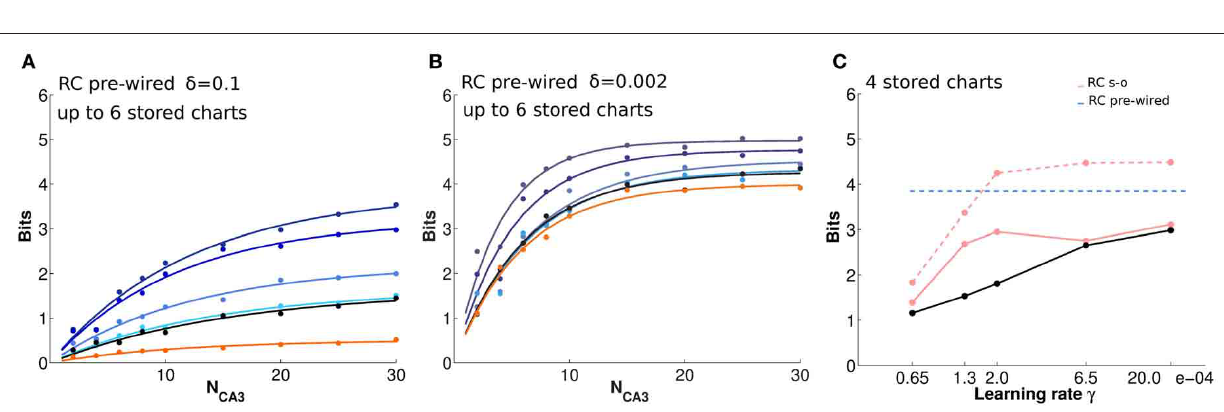
after mossy fiber inputs are turned off. (B) Fraction of CA3 units with at least a place field (3-bars group on the left) and fraction of those with multiple fields among those with at least one (3-bars group on the right). Same color coding as in the frames of the (A) .